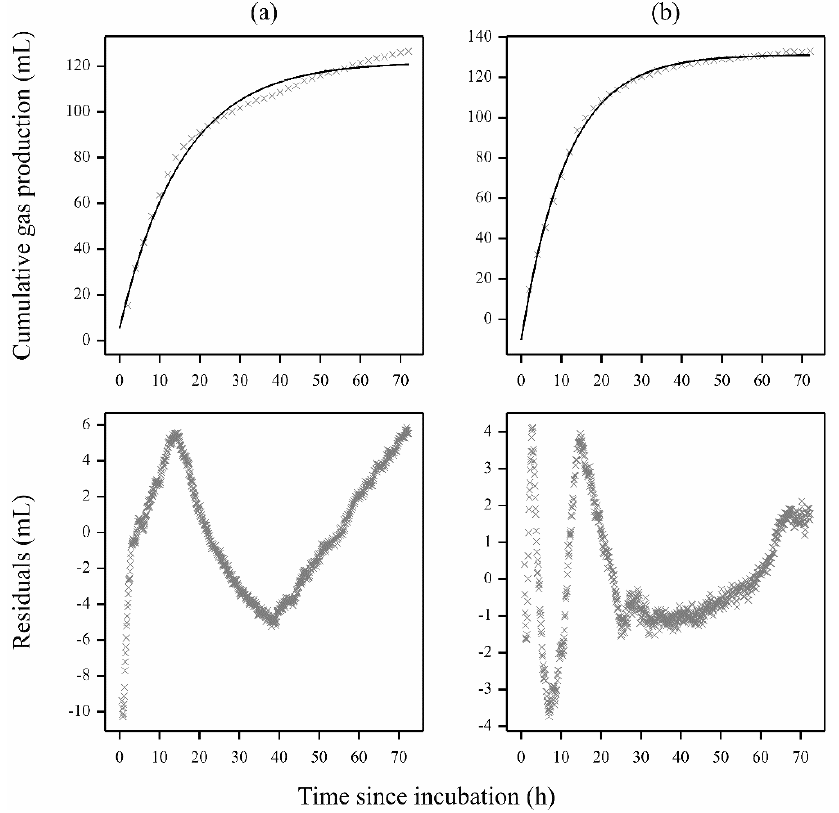
Figure 3. Example of monophasic gas production profiles taken from Garber et al. [19] with nonde- script contaminating features: ( a ) control Treatment A (grass hay 50%, alfalfa 50%), ( b ) Treatment B (grass hay 50%, alfalfa 50%, yeast 0.011 g). The solid line shows the fitted model (simple Mitscherlich) and the crosses represent data points (only those taken every 2 h are shown with the fitted curves).